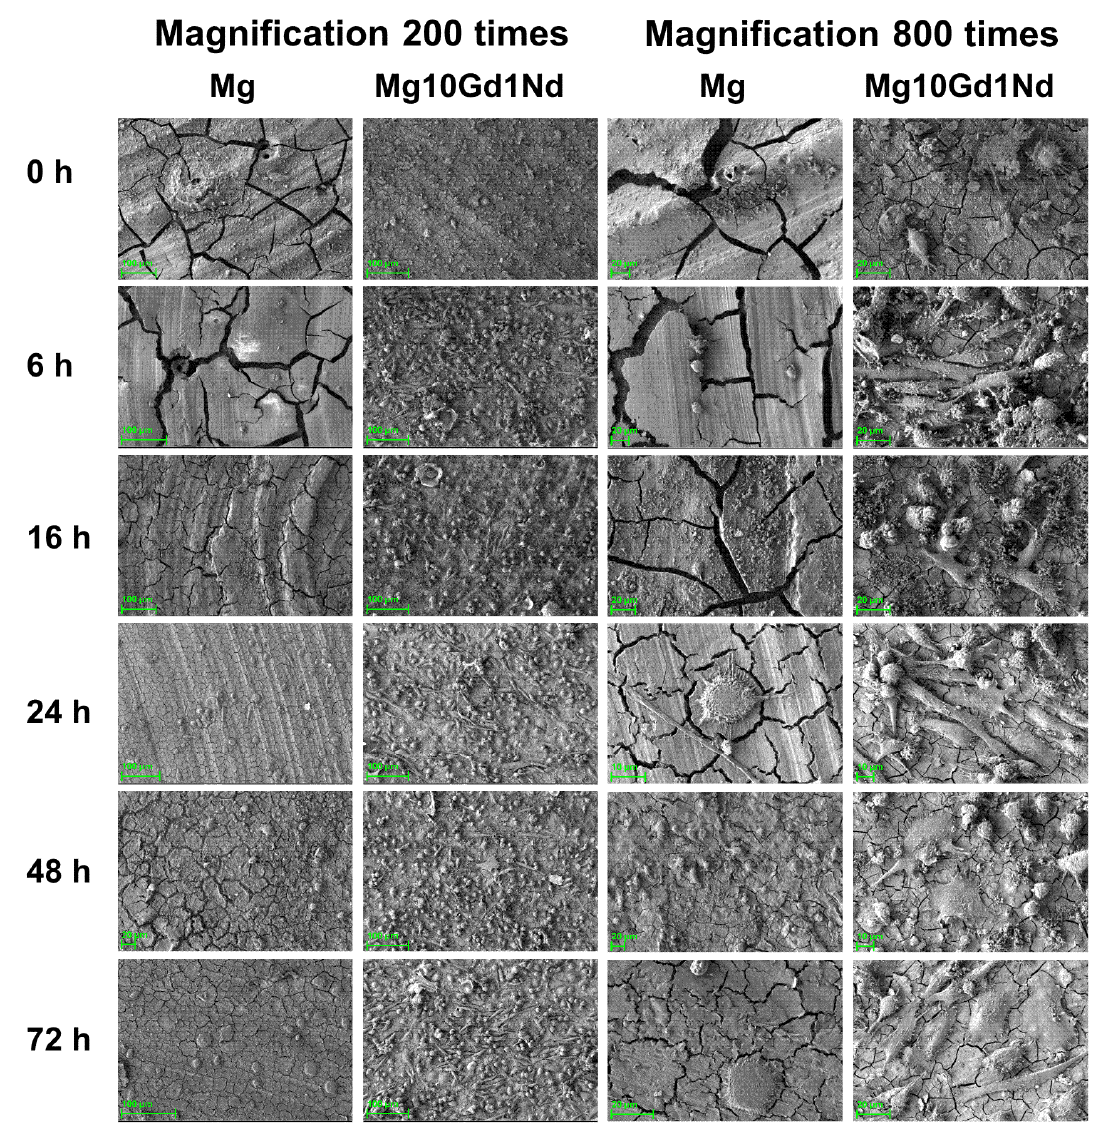
Figure 3. SEM images of Saos-2 cells incubated on two materials with varying pre-incubation